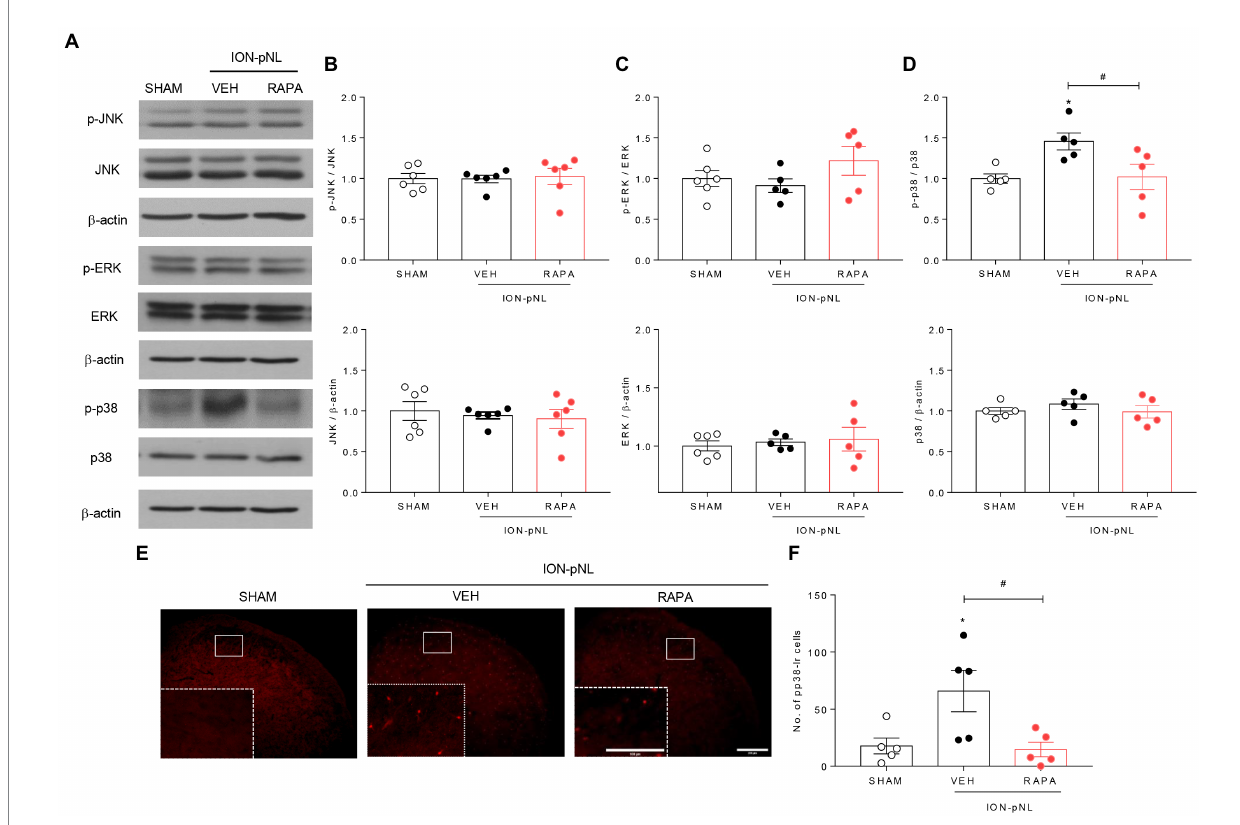
FIGURE 6 Effect of rapamycin on MAPK family expression in the TNC. Western blot analysis showed that both p-JNK and p-ERK expression did not change in the ION-pNL group compared with the SHAM group, and RAPA also showed no effect on p-JNK and p-ERK expression compared with the VEH-treated group (A–C) . On the other hand, the expression of p-p38 significantly increased in the TNC of the ION-pNL group (* p < 0.05 compared with SHAM), and RAPA completely reduced the increased p-p38 expression compared with VEH-treated mice (A,D) . # p < 0.05 compared with the VEH group, n = 5 per group. Immunohistochemistry revealed an increase in p-p38 expression induced by ION-pNL, which was also significantly reduced in the RAPA group (E,F) . * p < 0.05 and # p < 0.05 compared with the SHAM or VEH group, respectively, n = 5 per group. Scale bar = 200 μ m, 100 μ m in enlarged